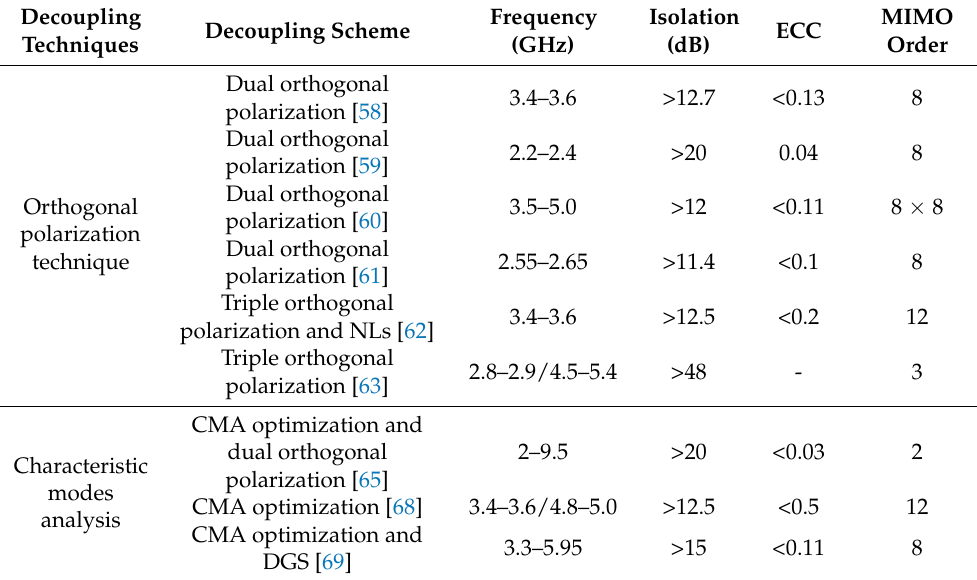
Table 3. Comparison among the referenced techniques of internal